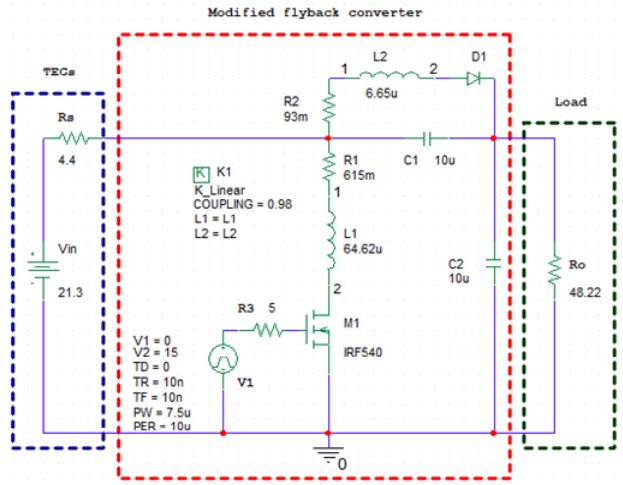
Figure 10. Simulation of the flyback converter in